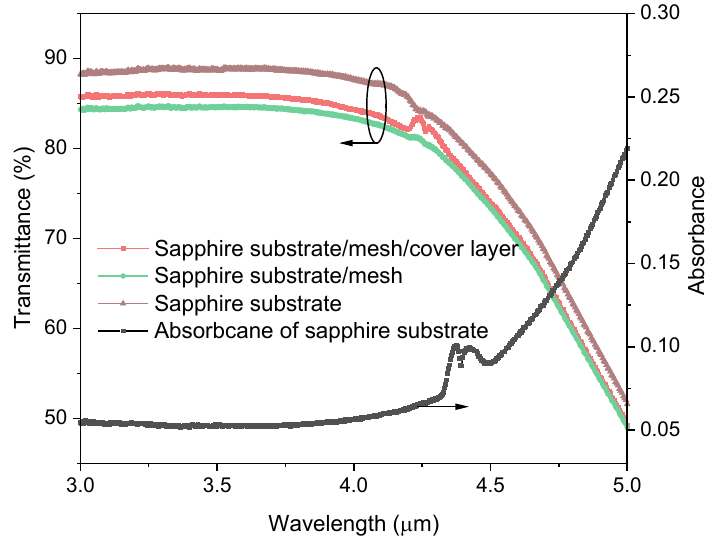
Figure 3. Optical properties of the transparent EMI shielding window.